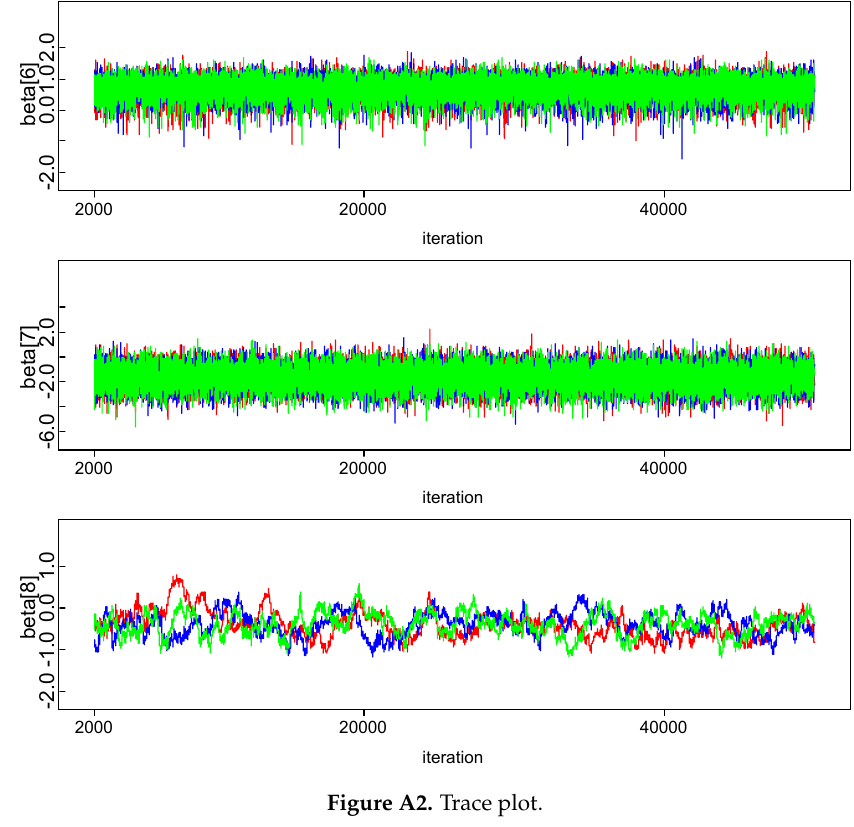
Figure A2. Trace plot.